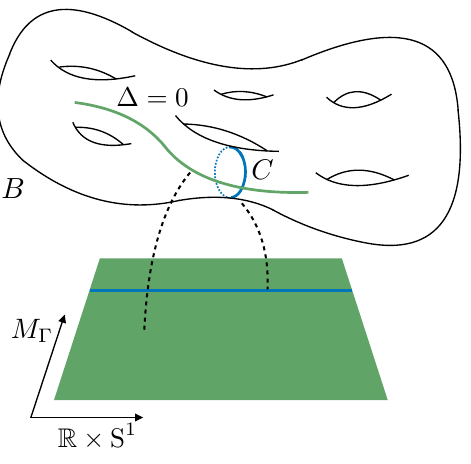
B and extend along the (cid:26) B and extends along R S 1 . (cid:26) (cid:2)